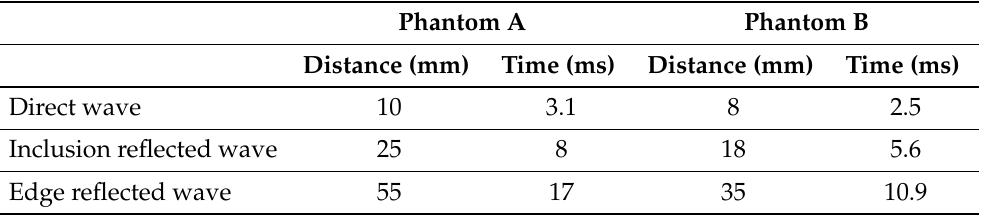
Table 3. Time-of-flight estimation for the direct wave, the reflection against the inclusion, and the reflection against the outer surface in both phantoms.